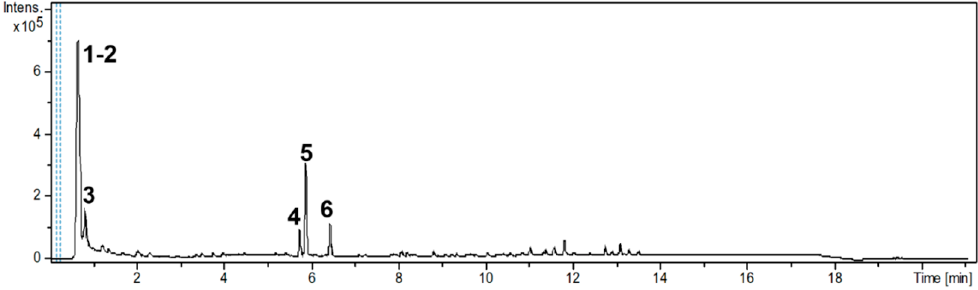
Figure 1. UV chromatogram of CSEE obtained by UPLC/DAD-ESI/HRMS/MS analysis ( λ 190–800 nm).